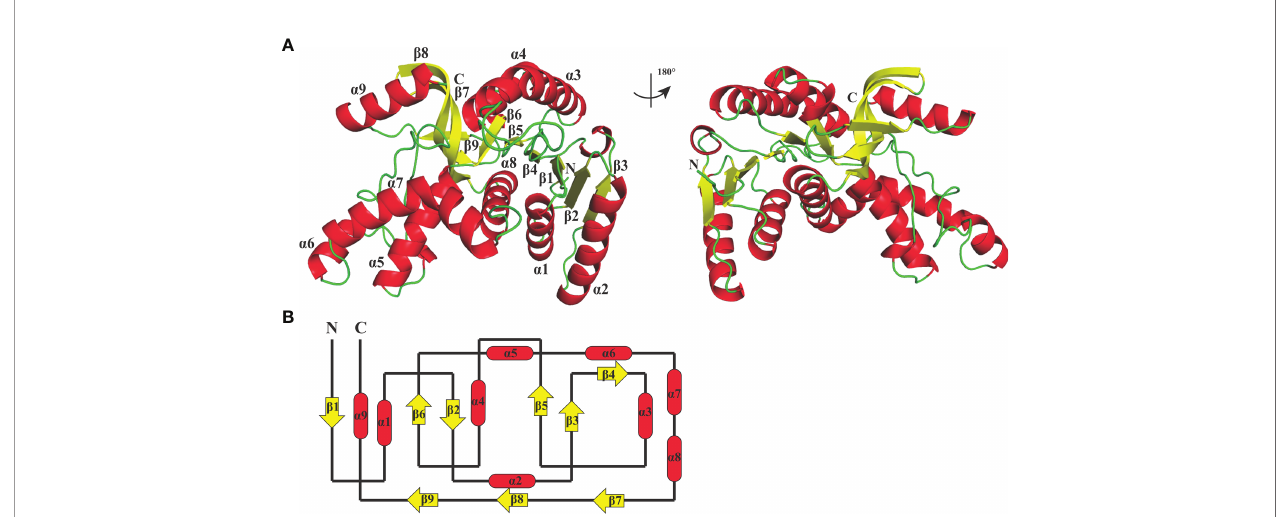
FIGURE 4 | Crystal structure of BoLDH. (A) Monomeric structure of BoLDH. The structure of BoLDH was exhibited as a cartoon structure and colored from N- terminal to C-terminal. The a -helicesis and the b -strands were colored in red and yellow, respectively. The mobile b 4- a 3 loop of BoLDH was shown with black dotted line. (B) Topology structure diagram of BoLDH. The topological structure of BoLDH was displayed and the colors were corresponding to that of the panel (A) All the cartoons were produced using Pymol viewer 4.30.